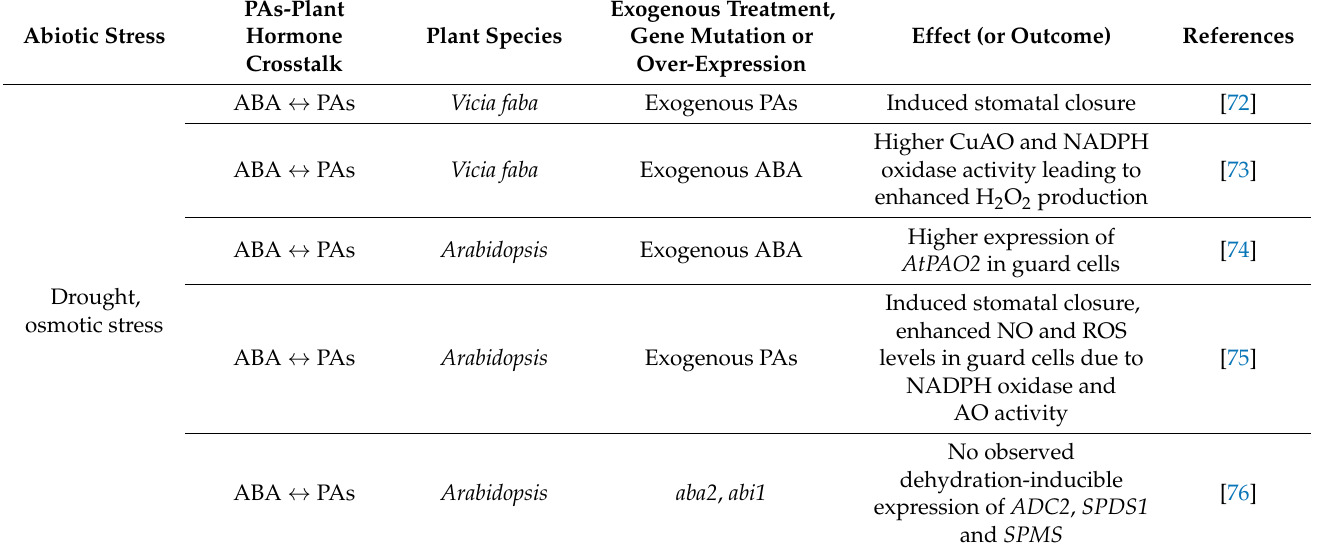
Table 2. Summary of evidence for the interaction between PAs and plant hormones in response to abiotic